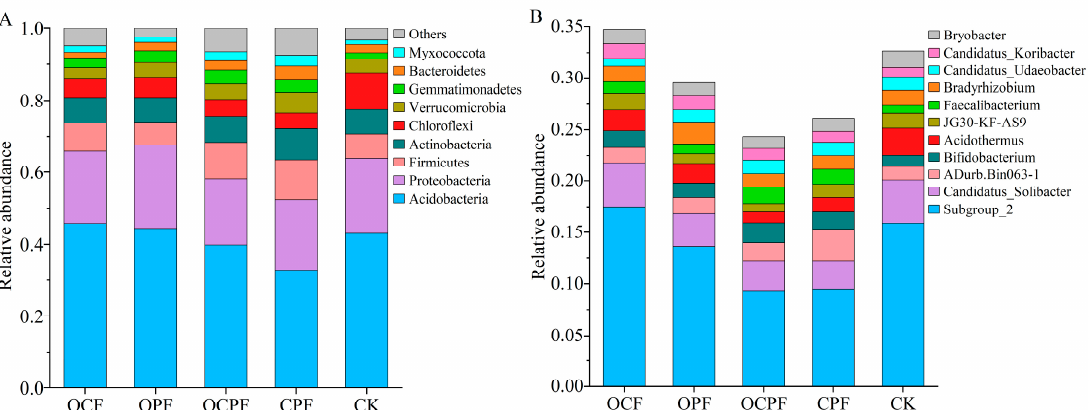
Figure 2. The relative abundance (>1%) of dominant bacteria at the phylum ( A ) and genus ( B ) levels. OCF, application of organic fertilizer and NPK compound fertilizer; OPF, application of organic and CaMgP fertilizers; OCPF, application of organic, NPK and CaMgP fertilizers; CPF, application of NPK and CaMgP fertilizers; CK, no fertilization.